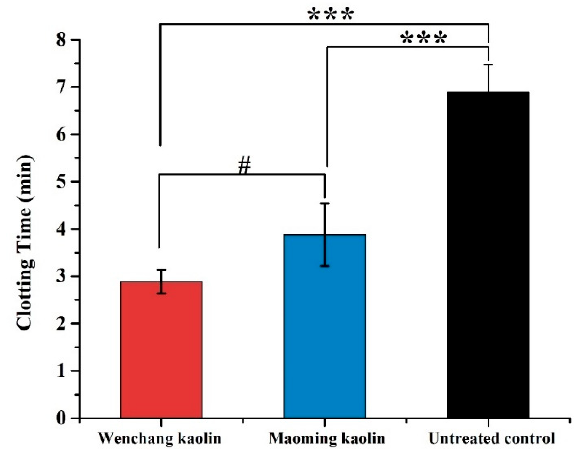
Figure 7. WBCT of two kaolins and untreated control ( n = 5). (*** indicates extraordinary difference with untreated control and p < 0.001, # indicates significant differences between the WBCT of the two kaolins and 0.01 < p < 0.05).